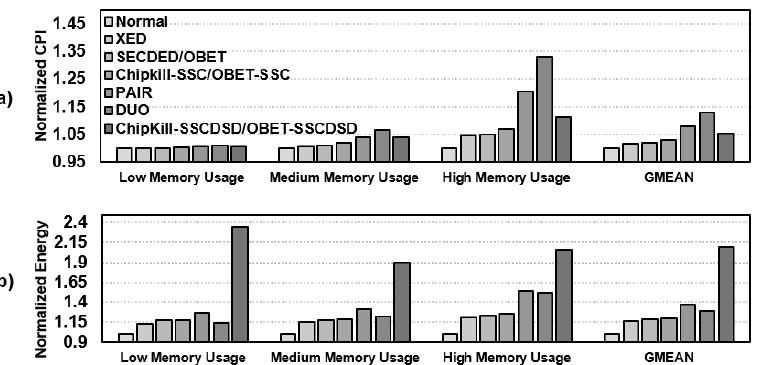
Figure 8. Simulation results for OBET-based techniques and state-of-the-art works on various applications: ( a ) normalized cycles per instruction (CPI) and ( b ) normalized energy